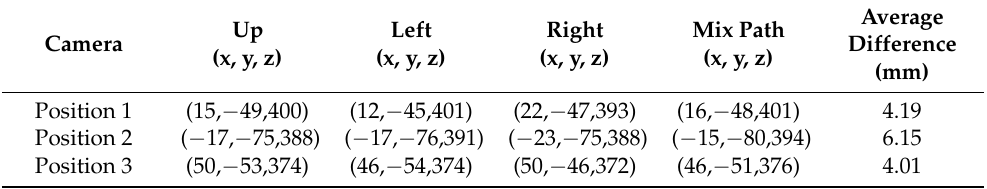
Table 1. The 3D coordinate value of pruning points was detected from twelve camera moving